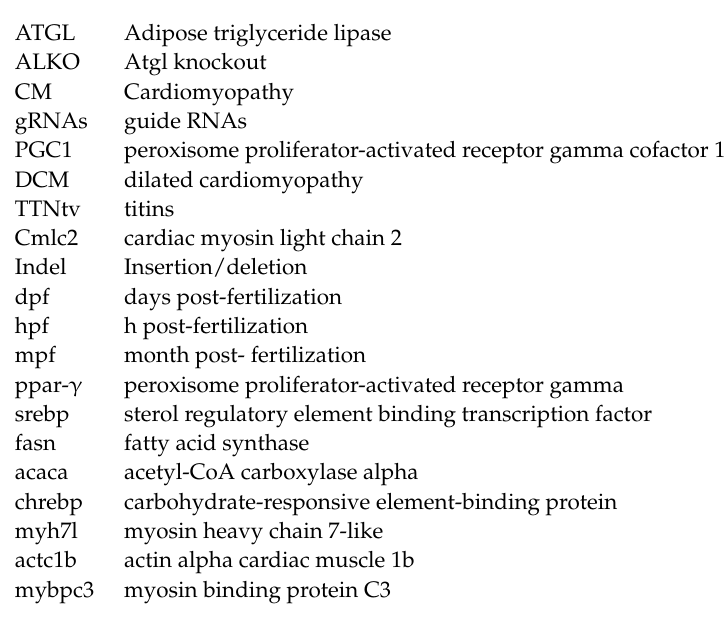
gRNA cassettes. Table S2: Primer sequences used for quantitative